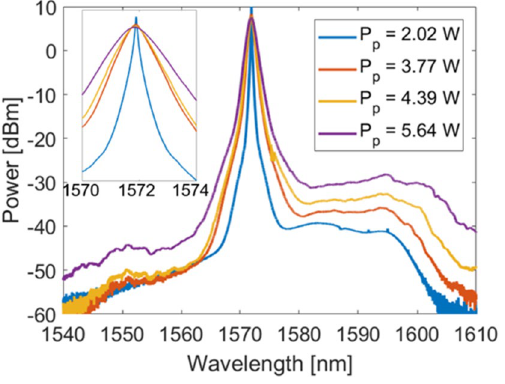
Figure 1. Output spectra of the random laser at various pump powers. The inset on the left shows the laser linewidth